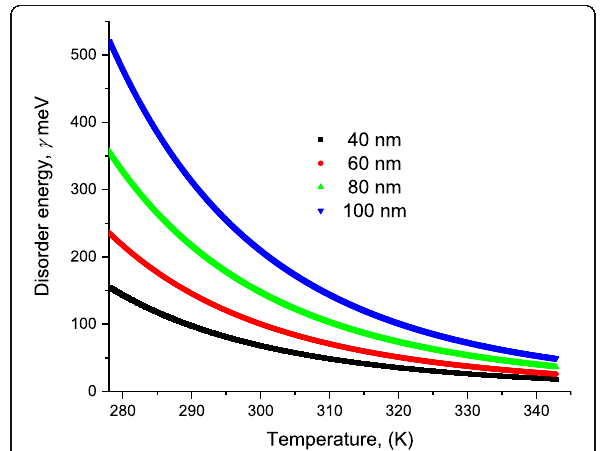
Fig. 10 The DC-electric current, calculated from Eq. (6), as a function of temperature for different disorder